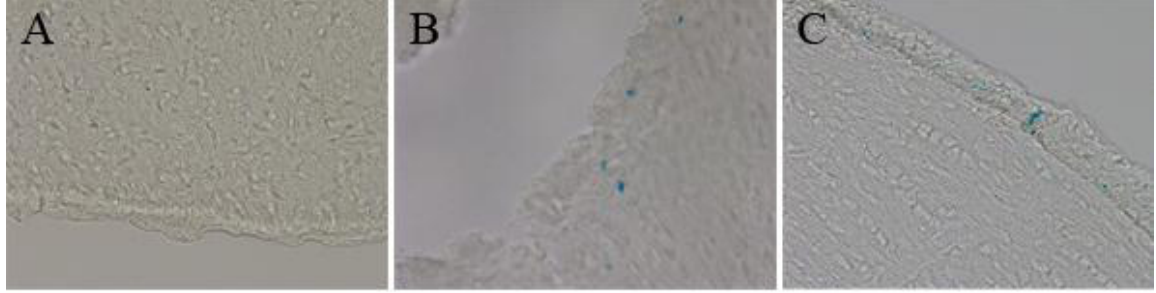
Figure 6. Iron-containing MNPs in brain. ( A ) Section from a non-injected brain. Without DAB-intensification, iron is not detected. On the contrary the brains of lip-MNP ( B ) and chi-MNP ( C ) injected animals displayed iron-containing MNPs. Magnification 400×.